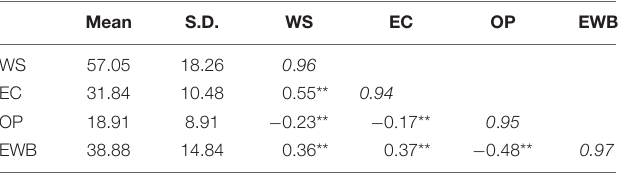
TABLE 1 | Descriptive statistics, Cronbach’s alpha and correlation coefficients among